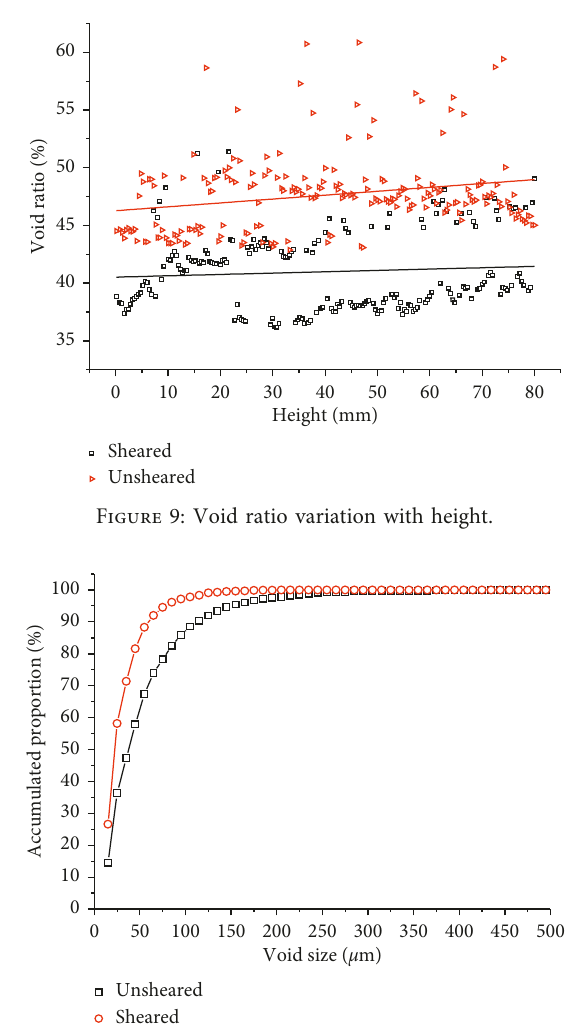
Figure 11: Correlation of permeability and void